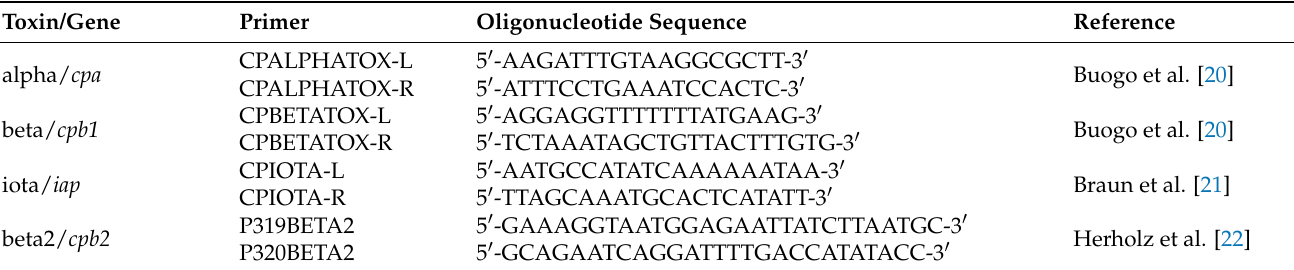
Table 2. Oligonucleotide primers for C. perfringens toxin gene